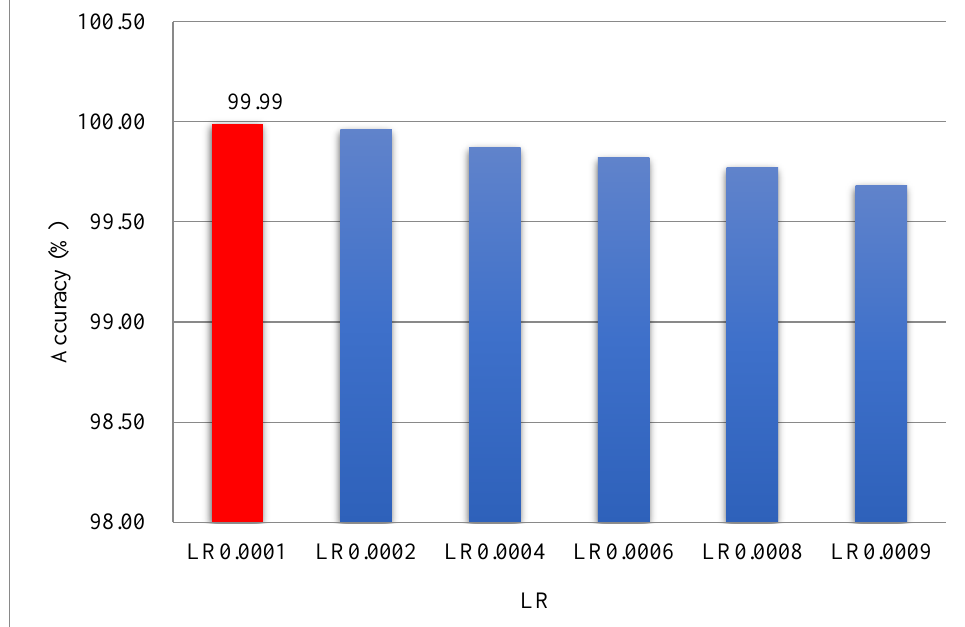
Figure 13. The average accuracy with different LRs.